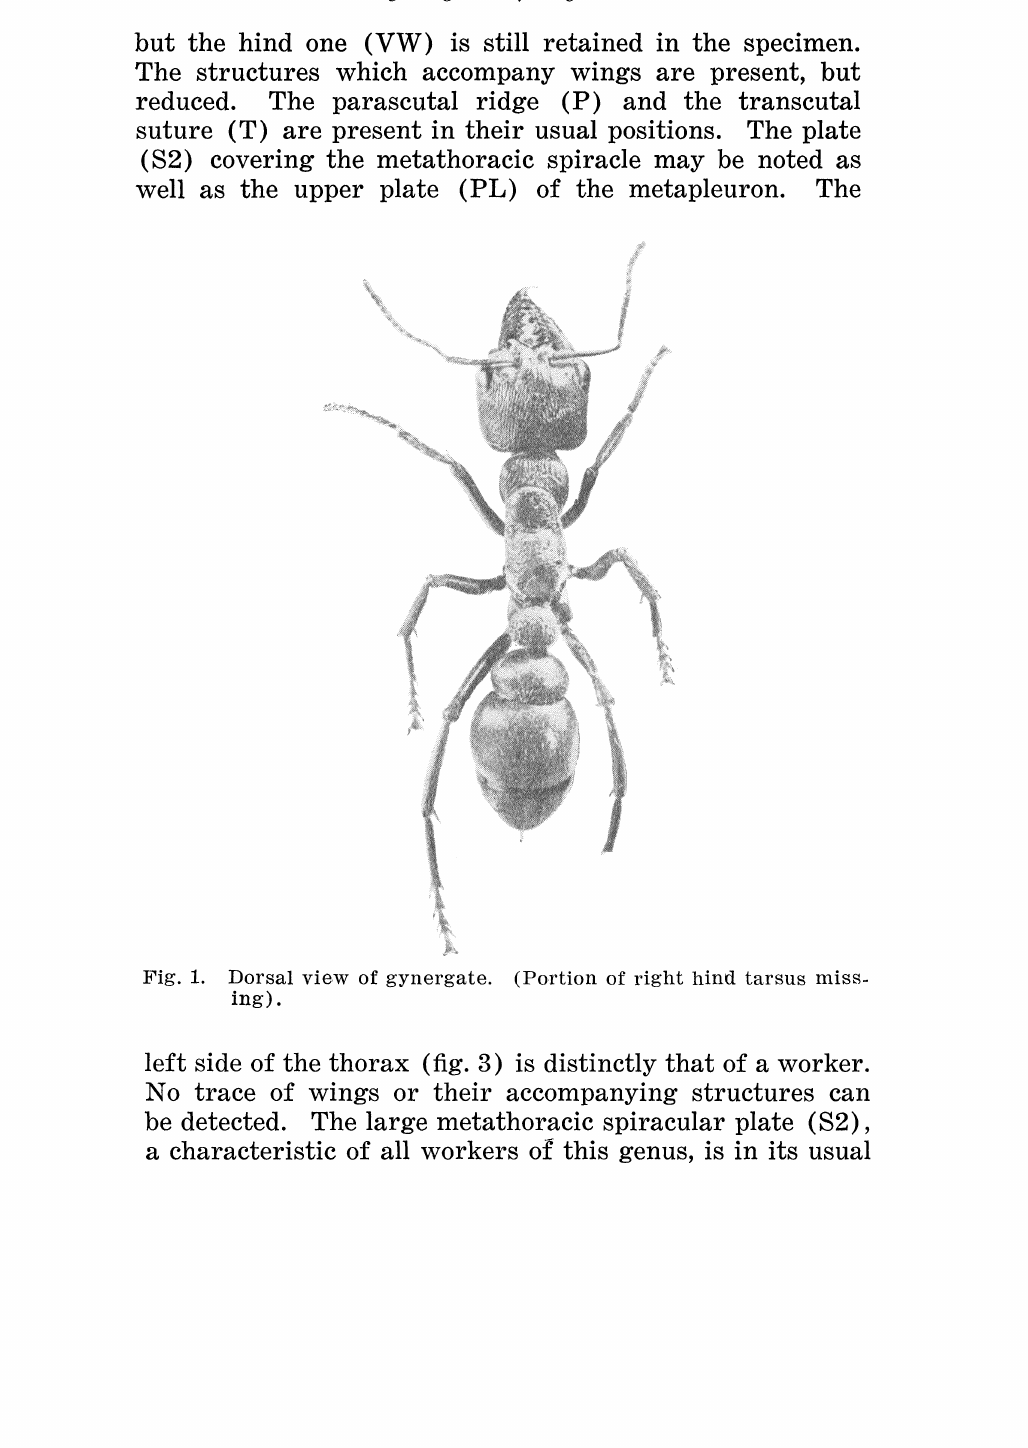
Fig. 1. Dorsal view of gynergate. (Portion of right hind tarsus miss- ing). left side of the thorax (fig. 3) is distinctly that of a